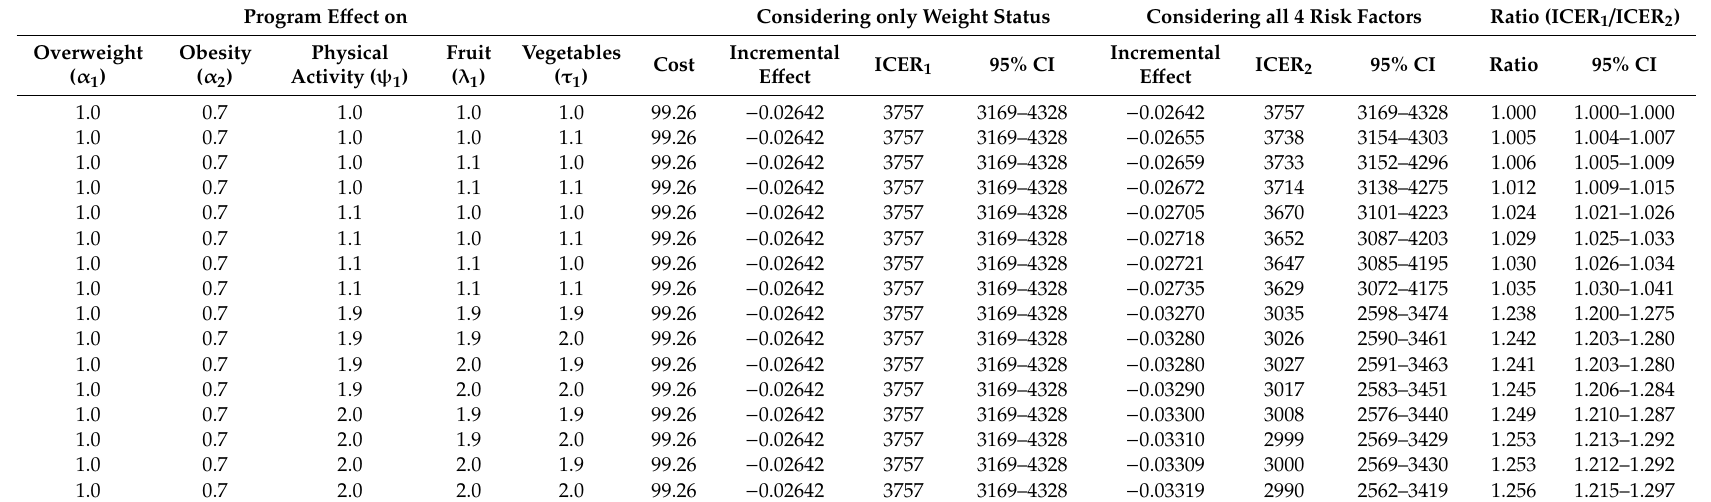
Table 3. Estimated incremental cost-e ff ectiveness ratio (ICER) for years with chronic disease prevented, considering e ff ects on all four risk factors compared to the e ff ect on weight status